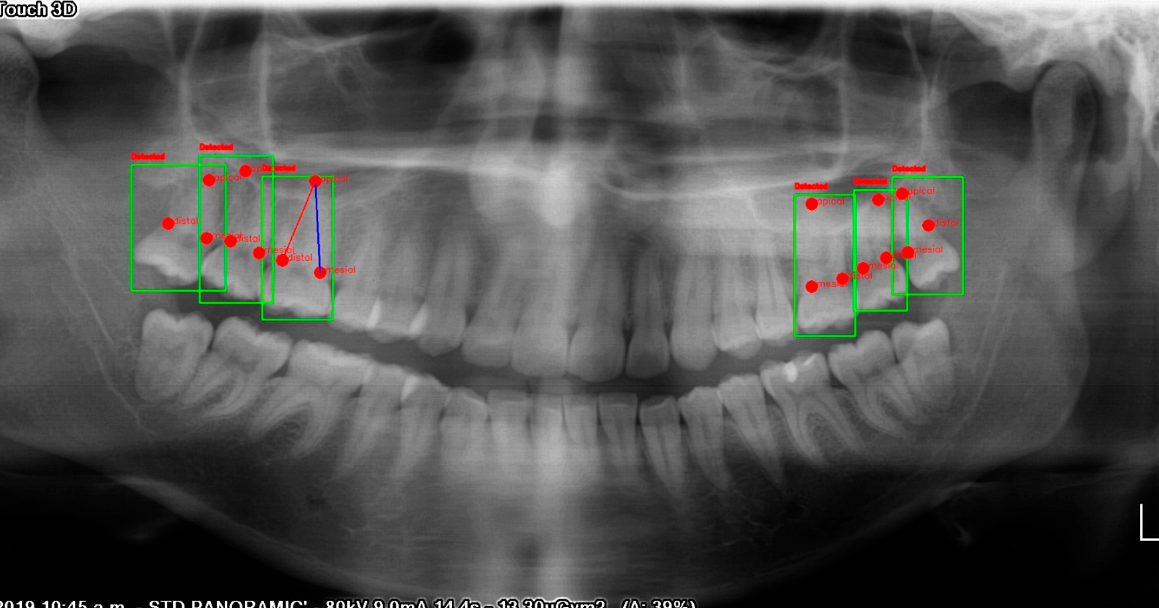
Figure 1. Automatic detection of upper molars and keypoints. The blue reference line illustrates the possibility of automatic distance measurements (e.g., in millimeters) in the case a reference line is available. Green boxes indicate detection (red text above green box: “Detected”). Red points indicate “mesial”, “distal”, and “apical” keypoints. Each tooth was assigned three keypoints (apical, mesial, distal). Apical keypoints were set at the most apical region of the root that could be identified. Mesial and distal keypoints were placed at the intersections of the radiographic bone and the teeth. All da- taset images were then resized (224 × 224). Using the Albumentation class in Python, ran- dom changes in brightness (brightness limit: 30%) and contrast (contrast limit: 30%) were applied as data augmentation techniques. To obtain more precise box drawings for the molars, polygons were converted to boundary boxes using Python code. Figure 2 illus- trates an example of the analyzed image structure.